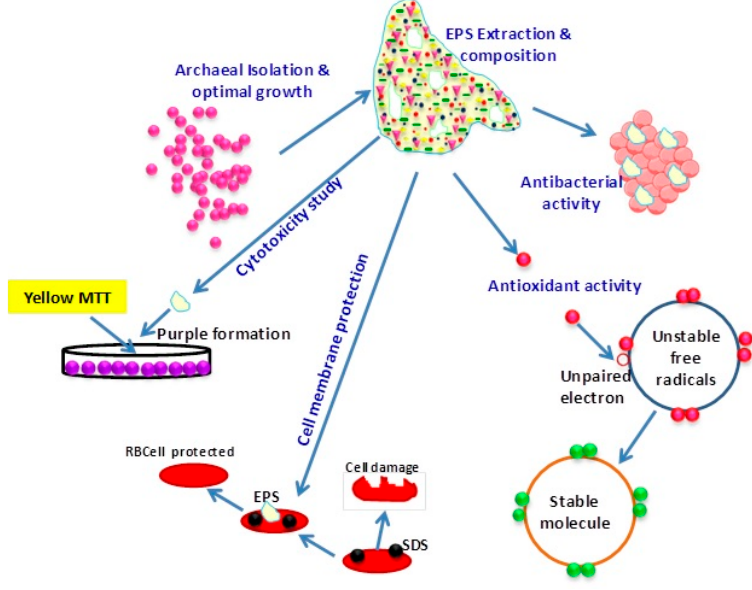
Figure 1. Archaeal EPS structure and their different biological activities.